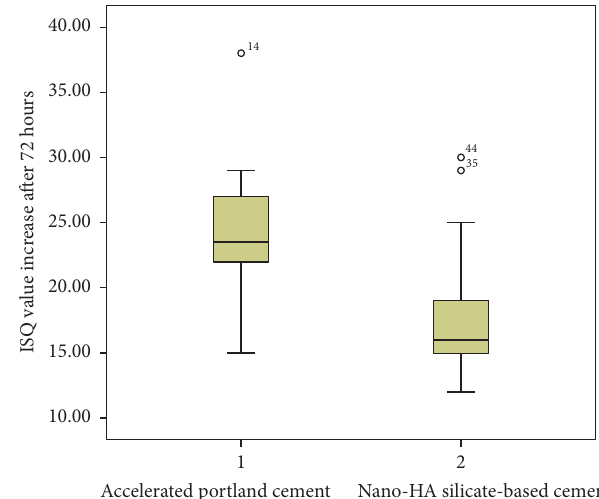
Figure 4: Primary stability improvements of dental implants after grafting the circumferential defects by different materials.